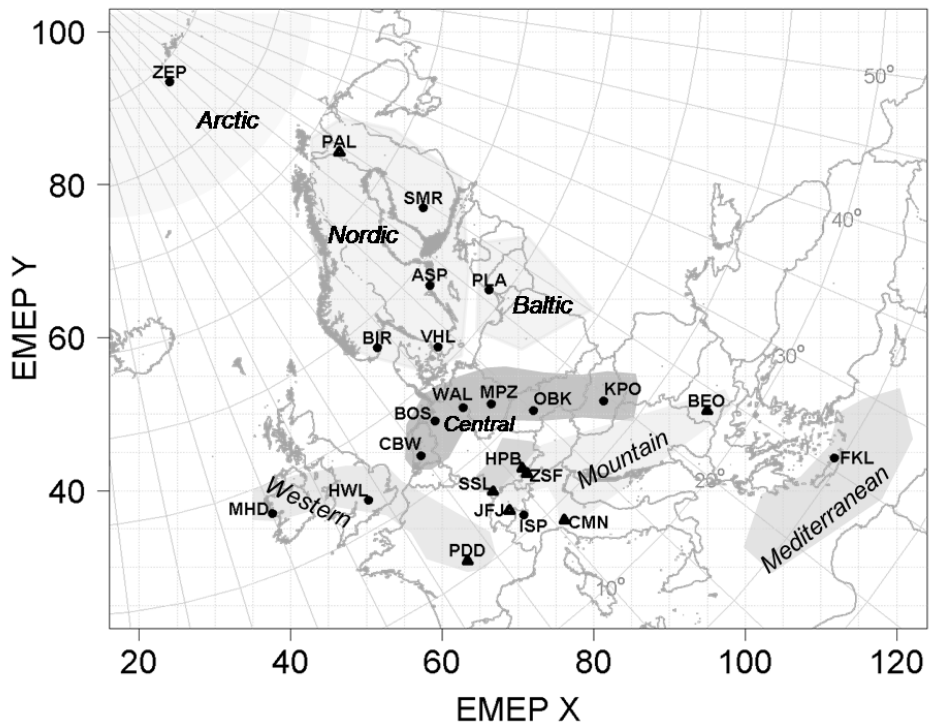
Fig. 1. Location of the 24 EUSAAR and GUAN stations in Table Figure 1. Location of the 24 EUSAAR and GUAN stations in Table 1